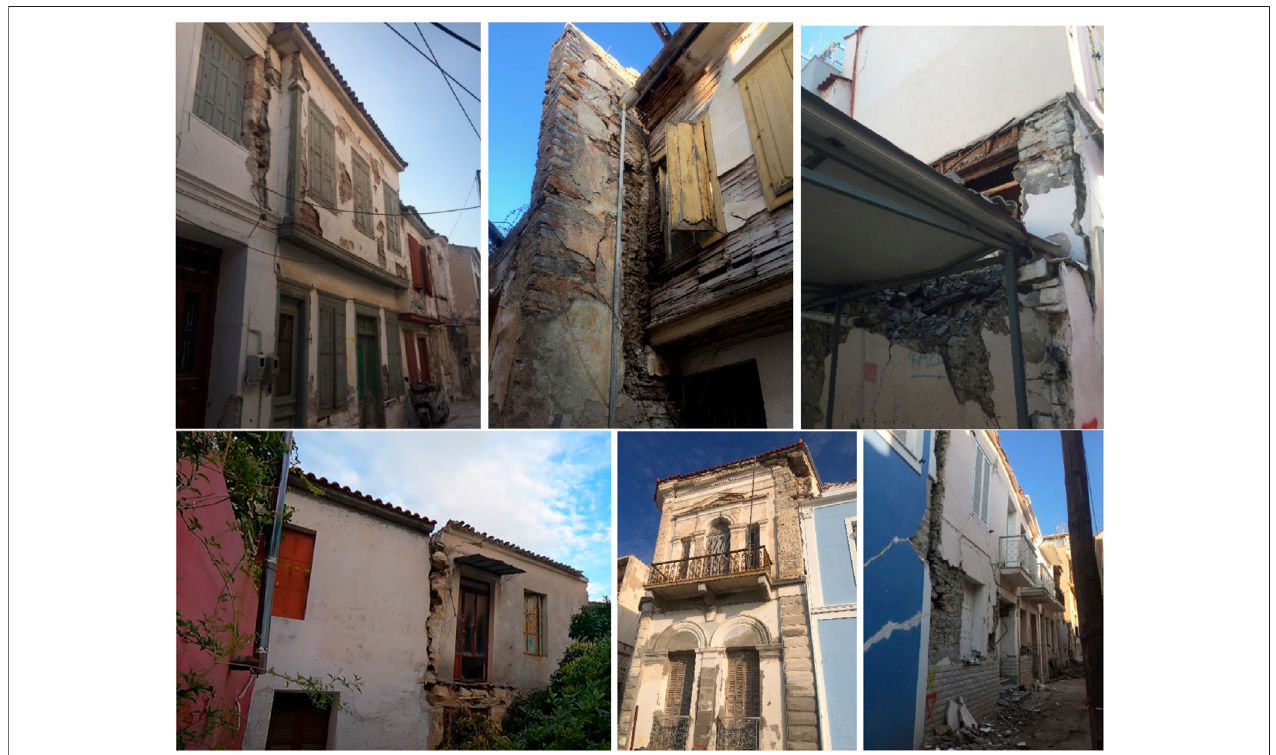
FIGURE7| Examples ofpounding induceddamageintimber-masonrystructures [DG2-DG3](Samos, Greece)Examplesofpounding induceddamageintimber- masonry structures [left picture from Mikres Diadromes Samou, 2020] [DG2-DG4] (all in Samos, Greece).